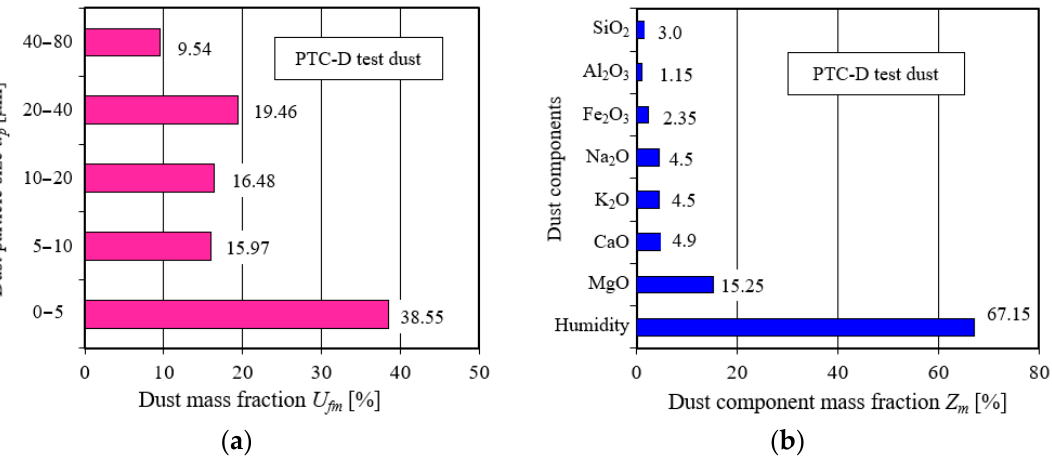
Figure 14. PTC-D test dust: ( a ) mass proportion of individual fractions in dust, ( b ) mass proportion of components in dust. Drawings made by the author based on data from [62].